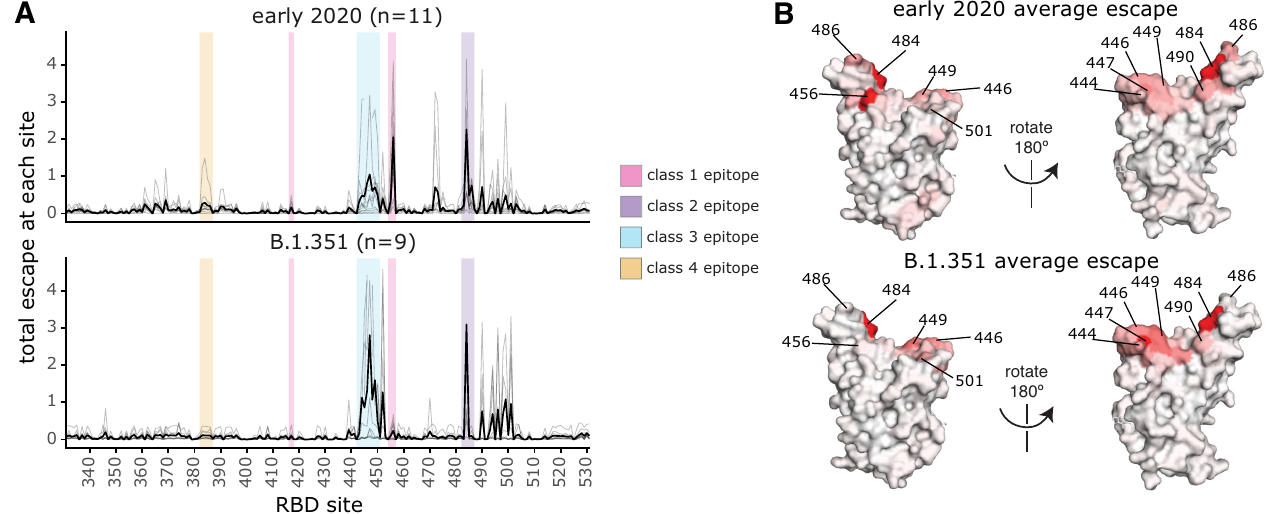
Fig 4. Comparison of binding escape mutations between plasmas elicited by infection with B.1.351 versus early 2020 viruses. (A) The total escape at each site is shown as a light gray line for each plasma in the early 2020 or B.1.351 cohorts. The thicker black line indicates the average for each cohort. Key antibody epitopes are highlighted, colored as in Fig 2A . (B) The total escape at each site averaged across each cohort is mapped to the Wuhan-Hu-1 RBD surface (PDB 6M0J [76]), with sites colored from white to red, with white indicating no escape, and red being the site with the most escape. Interactive versions of logo plots and structural visualizations are at https://jbloomlab.github.io/SARS-CoV-2-RBD_B.1.351/. The early 2020 escape-mapping data in this figure were originally published in [28] and are reanalyzed here. The full escape maps for the early 2020 samples are shown in S4 Fig and the full escape maps for the B.1.351 samples are shown in Fig 3